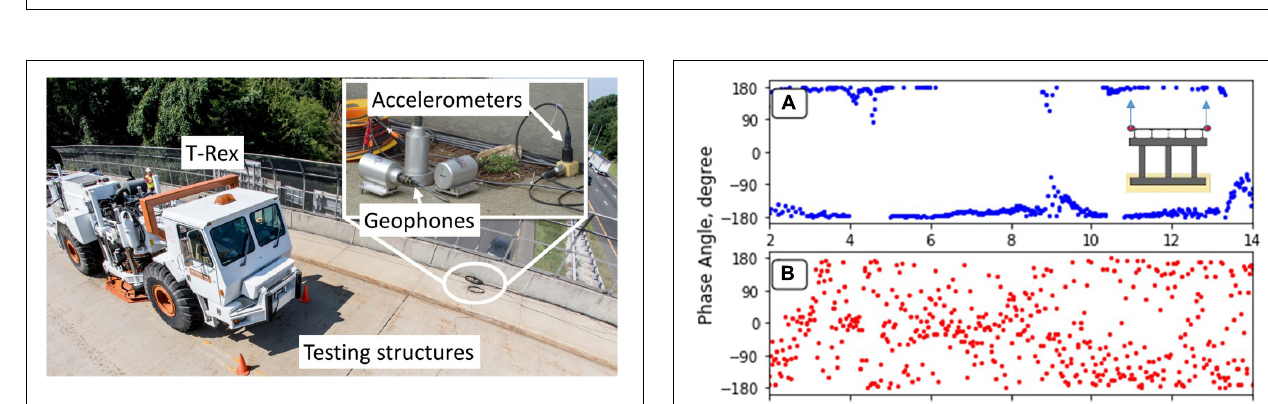
FIGURE 10 | Soil-type and P-wave velocity profiles showing the effectiveness of the microbially induced desaturation and precipitation (MIDP) method to desaturate natural soils: (A) Soil-Type Profile Based on CPT Data and (B) P-Wave Velocity Profiles (Stokoe et al., 2020).